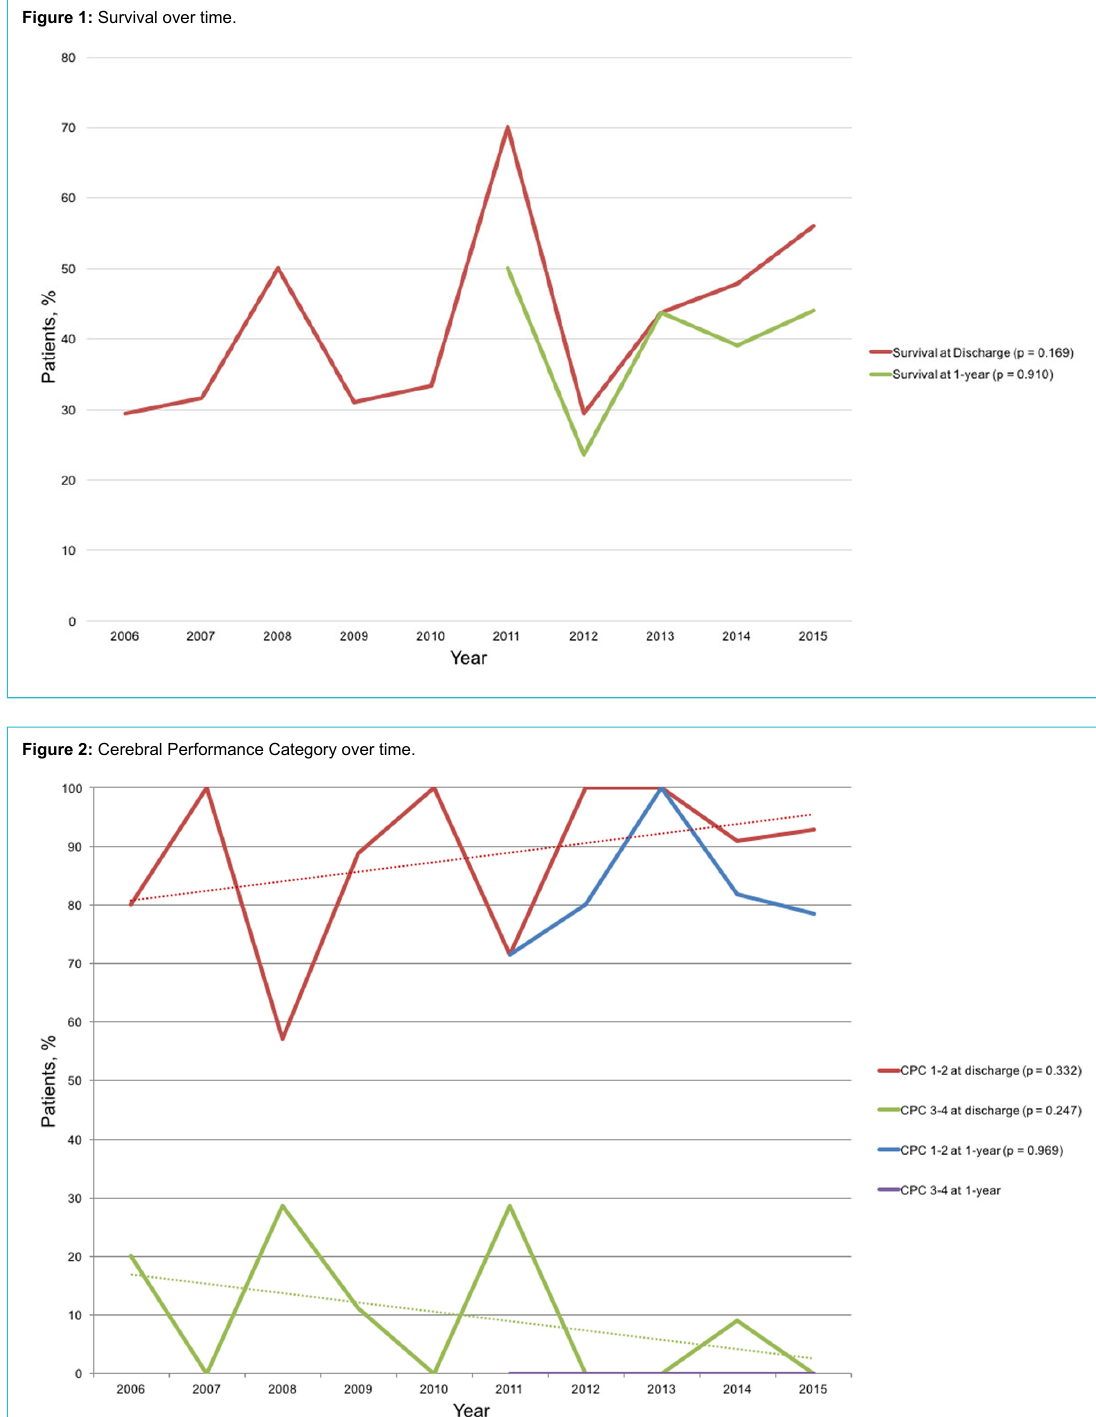
Figure 1: Survival over time.